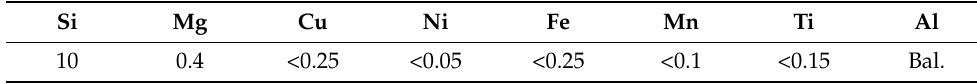
Table 1. Chemical composite of the AlSi10Mg Powder (wt.%).